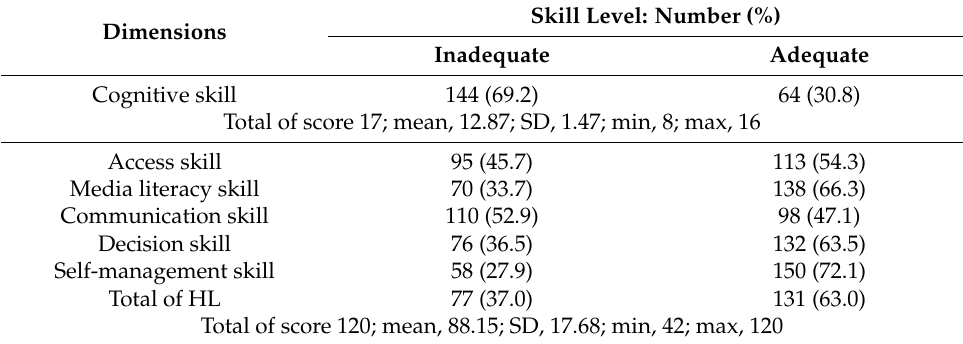
Table 2. Health literacy dimensions about TB ( n =